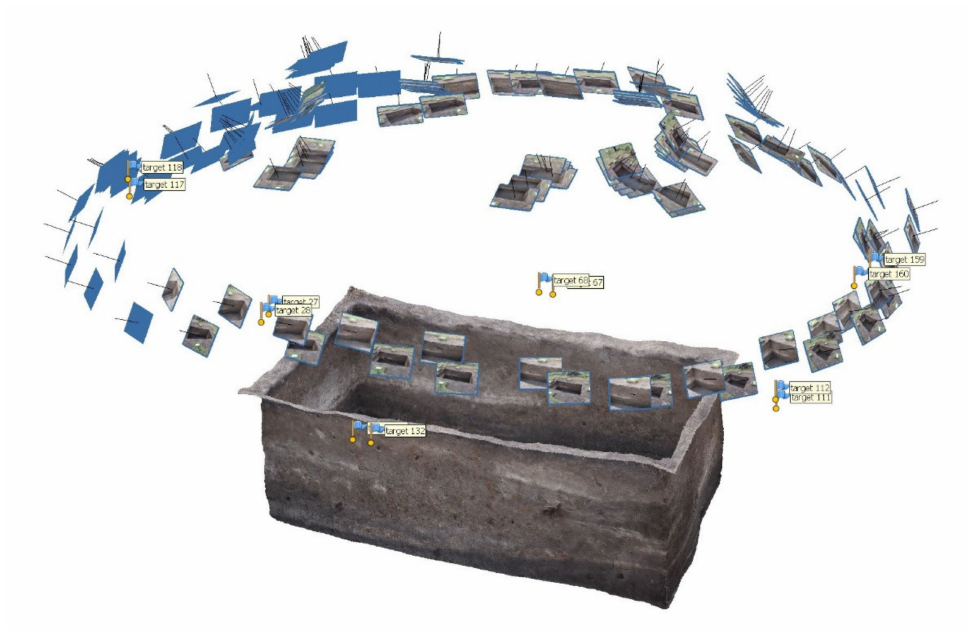
Figure 4. Example of the location of targets around a trench and the distribution of photographs taken to construct a model. The model depicted is that used for layer